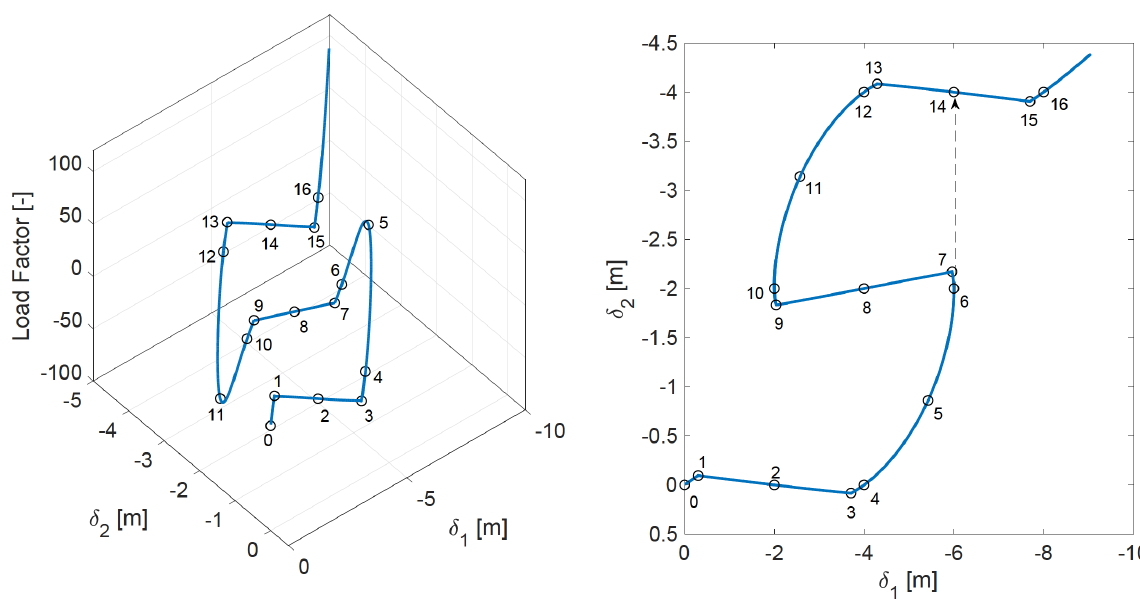
Figure 15: Sixteen-member structure load-displacement curves (Case 2 – λ up = 36.7 ): three-dimensional view (left) and top projection (right)